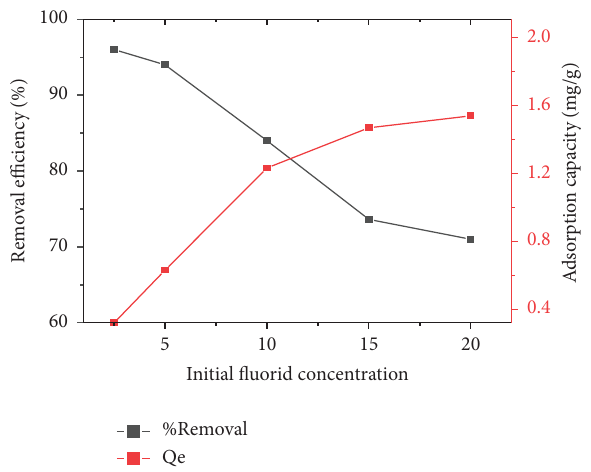
Figure 10: Te efect of initial fuoride ion concentration on the removal efciency and adsorption capacity.